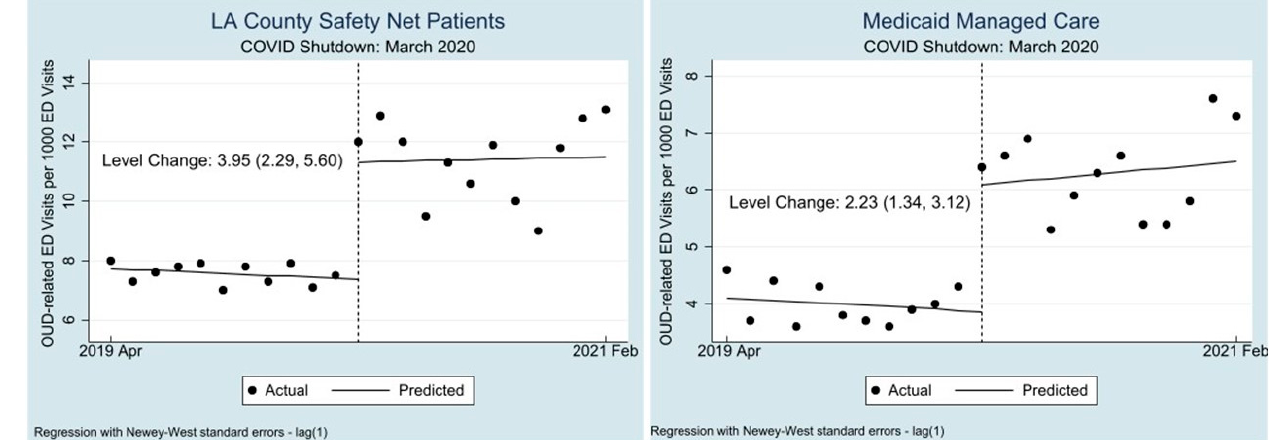
Figure A1. ITS Patients Experiencing Homelessness.